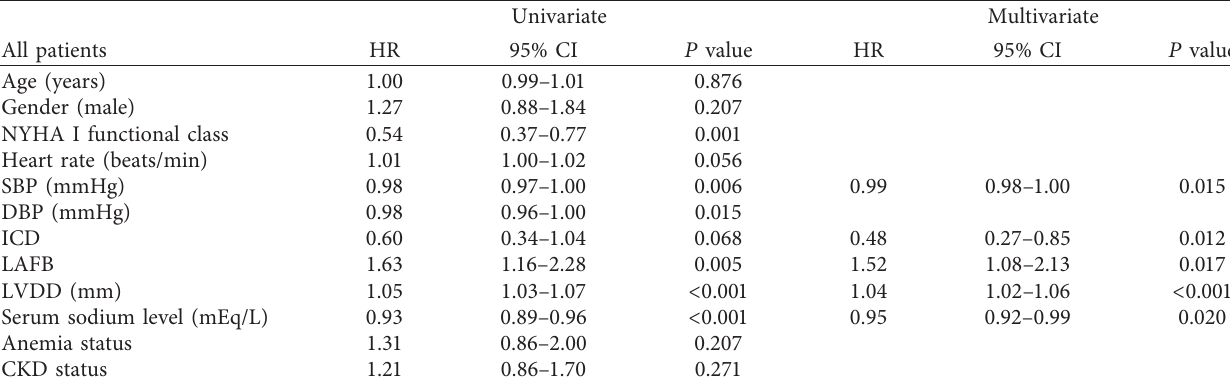
Table 3: Cox proportional hazard model analysis for independent predictors of all-cause